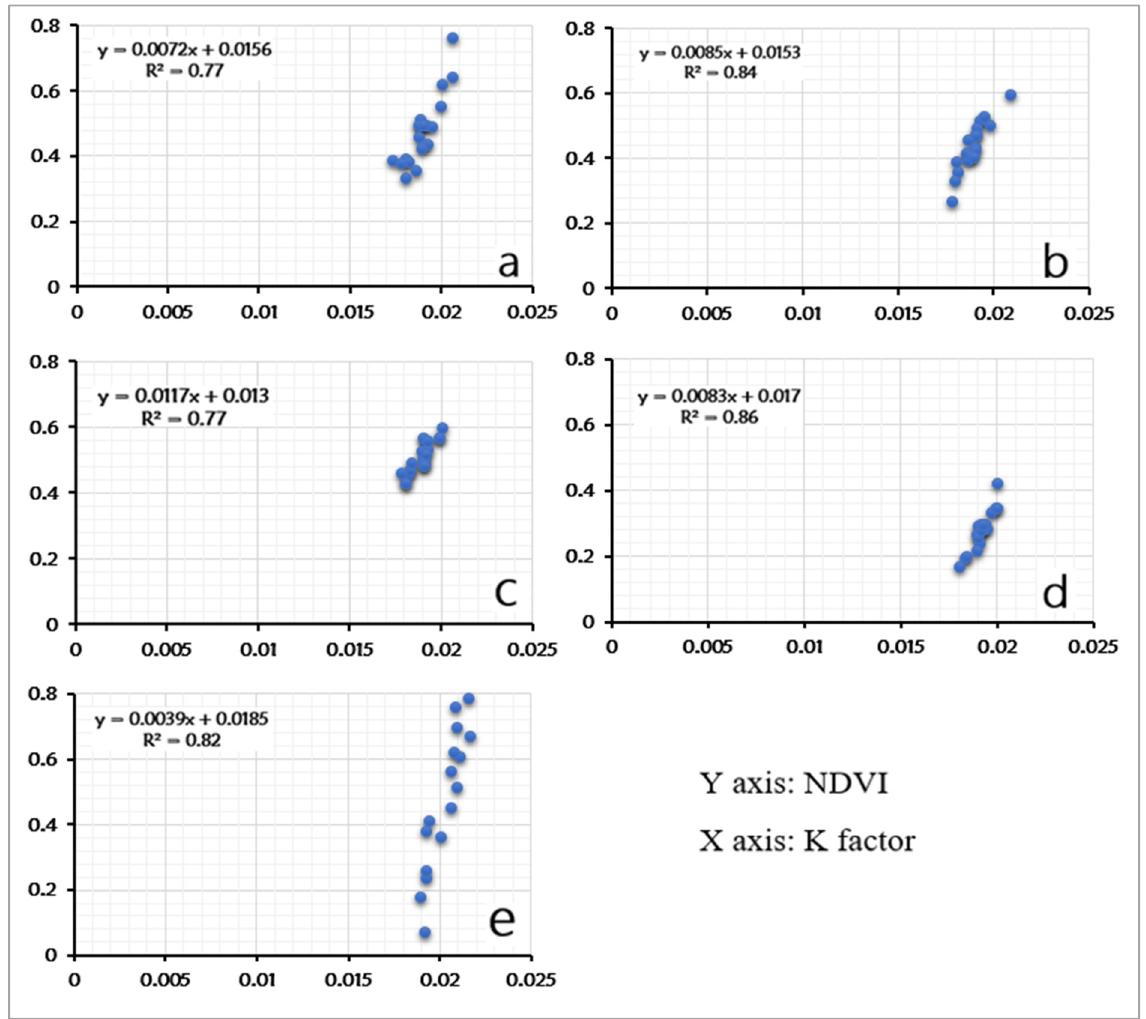
Figure 6. Impact of soil heterogeneity (classified as 1, K= 0.016 to 0.018; 2, K = 0.018 to 0.019; 3, K = 0. 019 to 0.02 and 4, K ≥ 0.02) on NDVI values for the period of study: ( a ) 2000, ( b ) 2005, ( c ) 2010 ( d ) 2015 and ( e ) 2018.